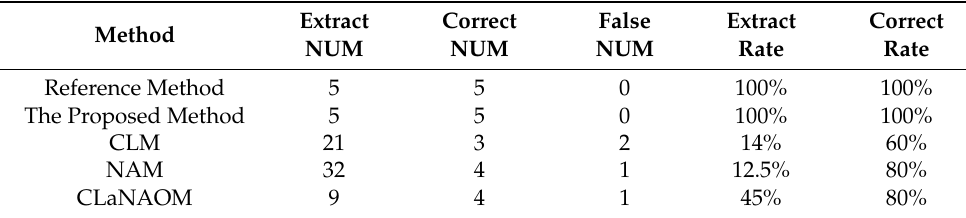
Table 4. Vertex extraction results for each method using the experimental first dataset.